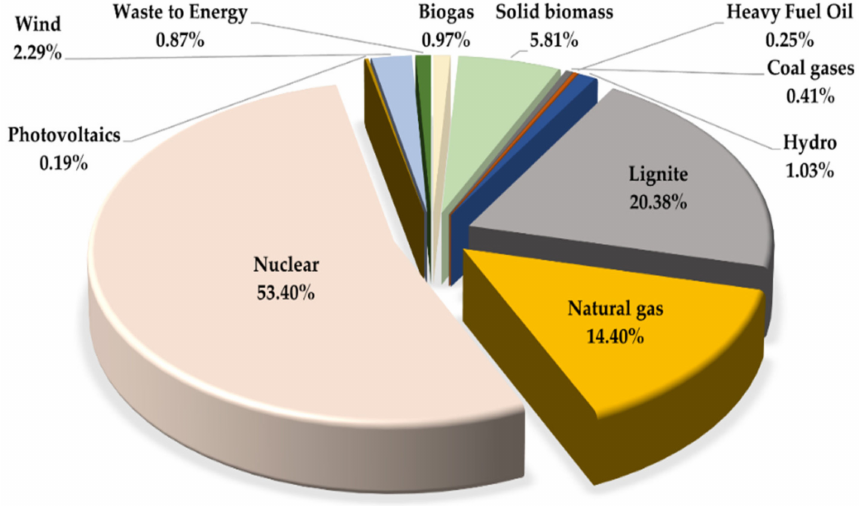
Figure 6. Electricity mix for Hungary (2021). (Source: GaBi 8.0